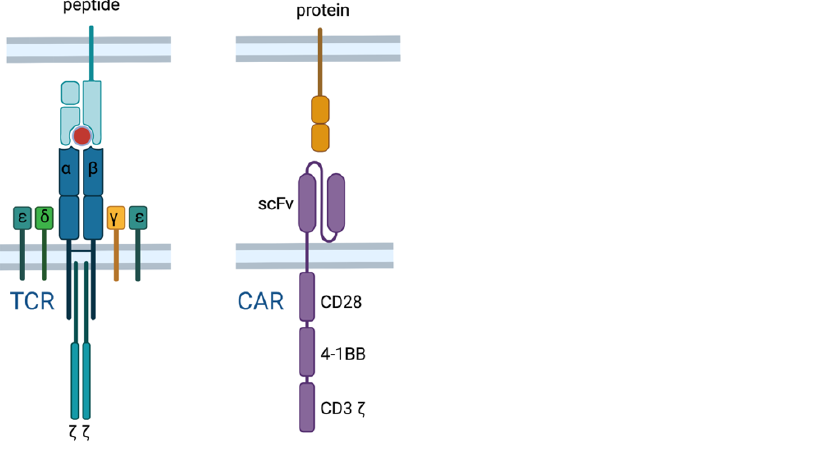
Figure 4. Transgenic T cell receptors (TCRs) and chimeric antigen receptors (CARs) redirect T cell specificity in distinct ways. TCRs recognize MHC-restricted peptides derived from either extracellular or intracellular proteins, whereas CARs bind their cognate MHC-independent antigen through an antibody-derived domain .